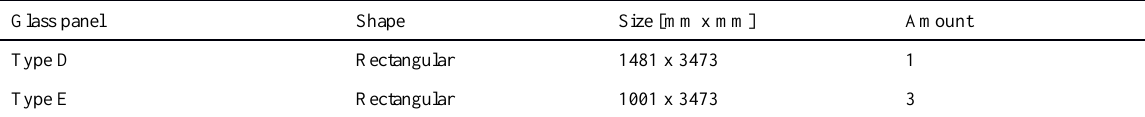
Table 3: Position of the laminated glass panels in the central parapet.